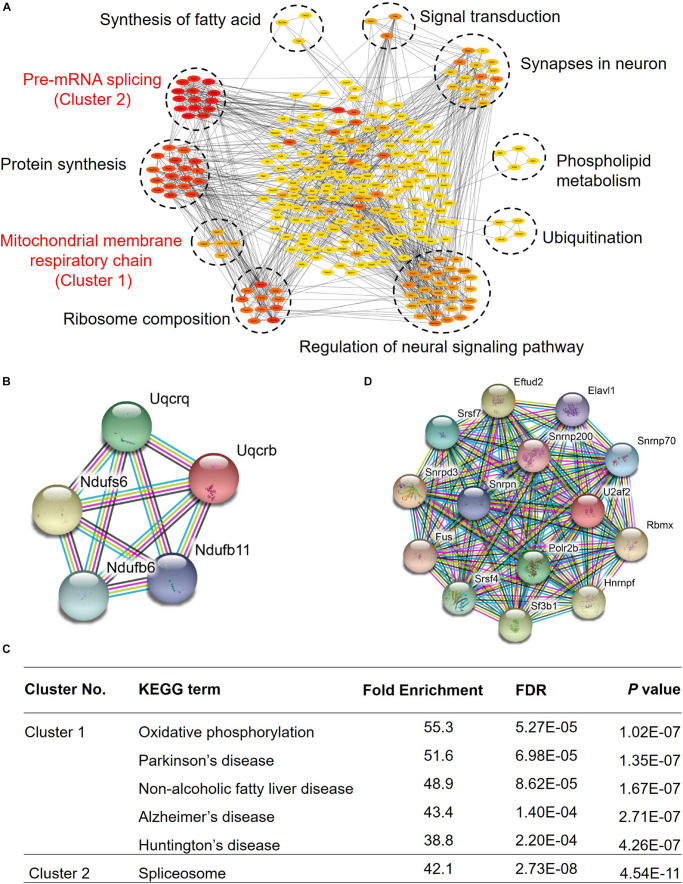
GAS5 RNA pull-down results revealed regulatory GAS5-associated protein–protein interaction network related to aging-associated diseases. (A) Overall protein–protein interaction network of GAS5 interacting proteins. Network nodes of different colors present proteins. Red color represents strong interaction, whereas yellow suggests a relatively weak connection. Lines between proteins represent protein–protein associations. (B) Interaction network diagram of proteins in first cluster, which were involved in the formation of mitochondrial membrane respiratory chain reaction. (C) KEGG pathway enrichment analysis of clusters 1 and 2. (D) Interaction network diagram of proteins in second cluster, which participated in the shearing process of pre-mRNA.